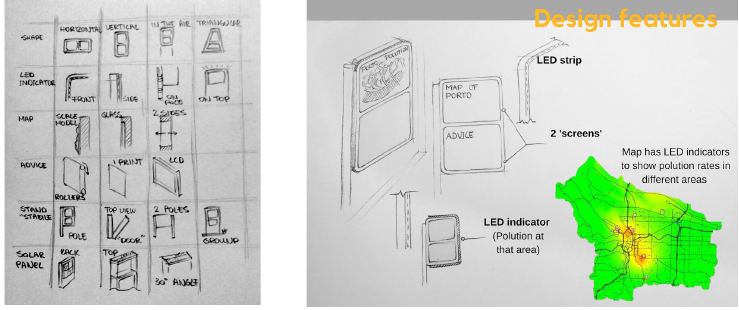
Fig. 2. Morphological scheme for the smart billboard (left), showing its different planned functions, and Billy design features (right)